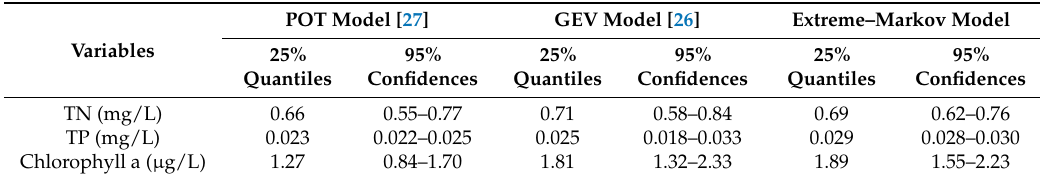
Table 3. The estimation of the reference conditions and 95% confidence intervals by the POT, block generally extreme values (GEV) and Extreme-Markov